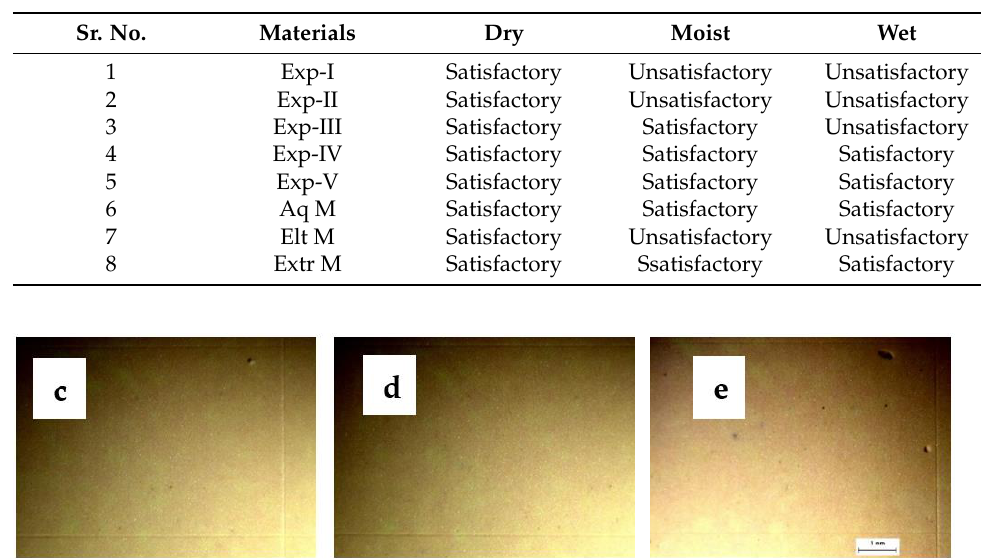
Figure 5. Compatibility with gypsum for commercial and Exp VPS (medium-bodied) impression materials under moist conditions, where (c) Elt M, (d) Exp-I, (e) Exp-II. The scale bar is 1